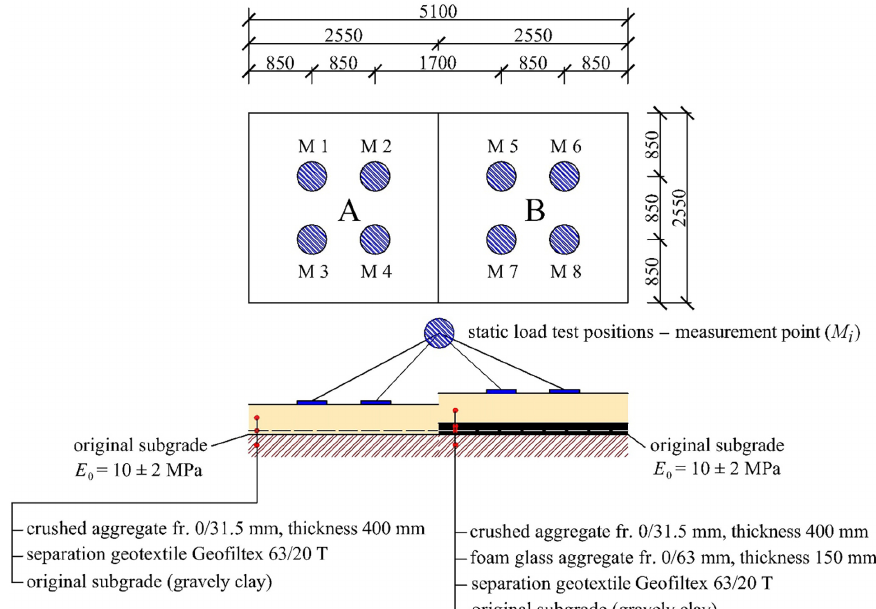
Figure 1. Experimental field: Segment A (standard sub-ballast layers), Segment B (modified sub-ballast